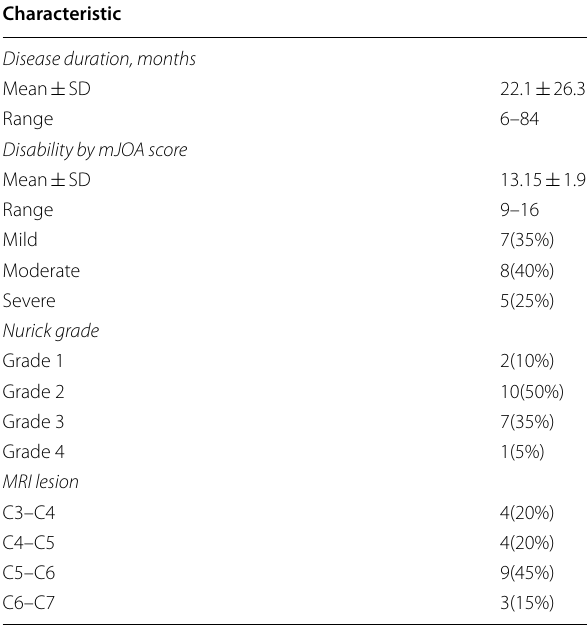
mJOA modified Japanese Orthopedic Association, MRI magnetic resonance imaging